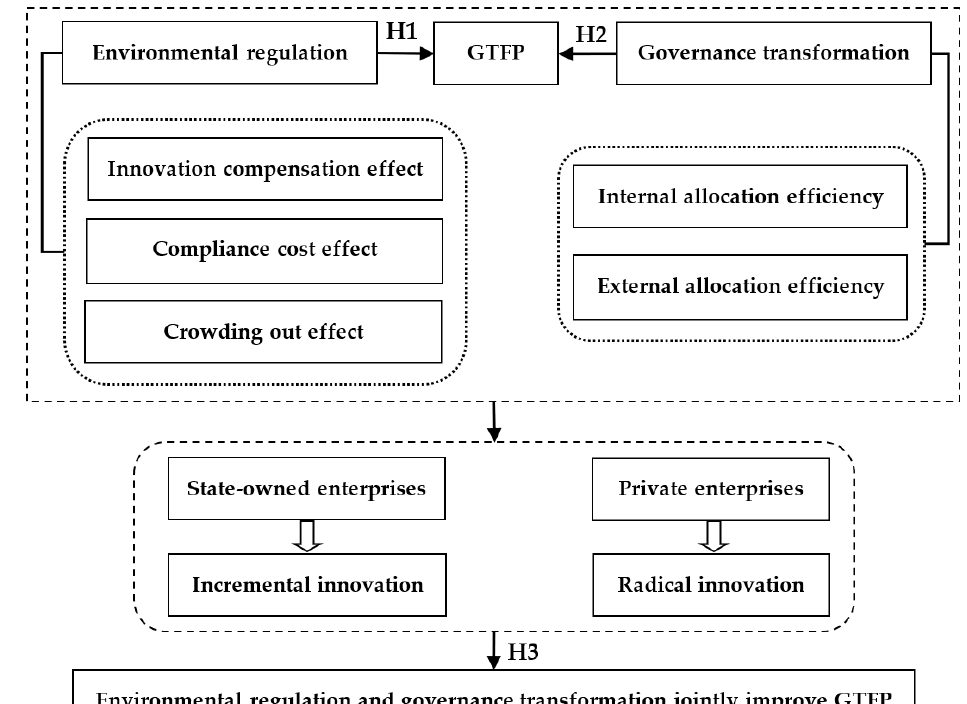
Figure 2. The theoretical mechanism diagrams of hypotheses.